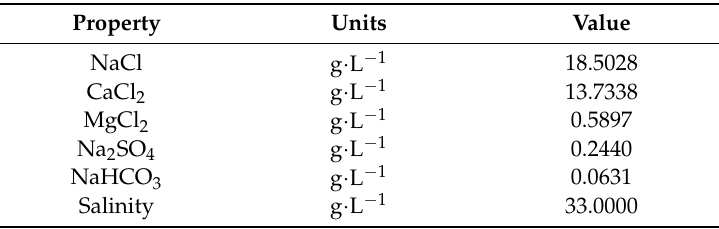
Table 3. Properties of simulated brine.